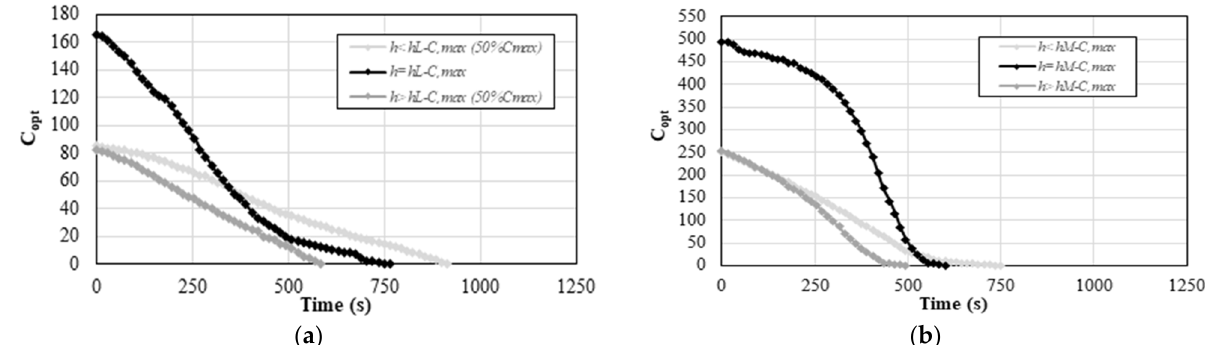
Figure 8. Reduction over time of C (cid:2925)(cid:2926)(cid:2930) for different values of h (cid:2896)(cid:2879)(cid:2887) and h (cid:2897)(cid:2879)(cid:2887) respectively in the case of Fresnel lens ( a ) and spherical mirror ( b ) in absence of secondary optics.